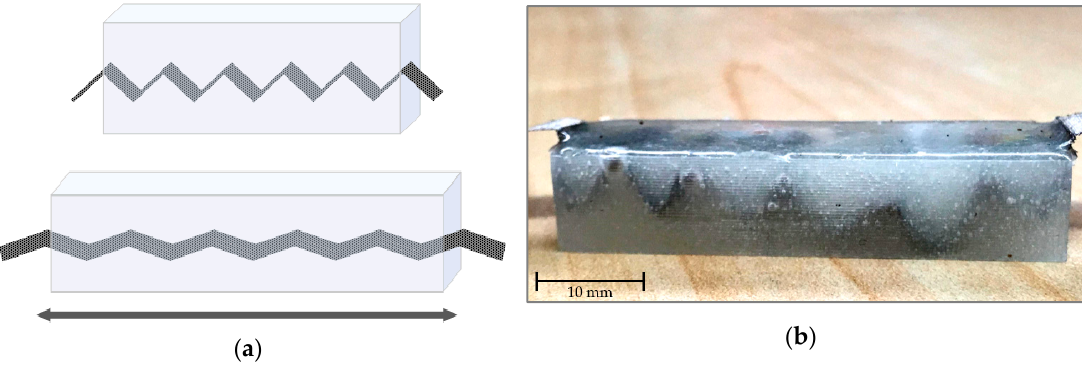
Figure 4. Accordion folding heating element. ( a ) Accordion fold fabric design compressed (top) and extended (bottom); ( b ) Side profile of accordion fold design in silicone sample. Pouring of silicone during molding shifted the heater in the silicone and created air pockets underneath the folds.